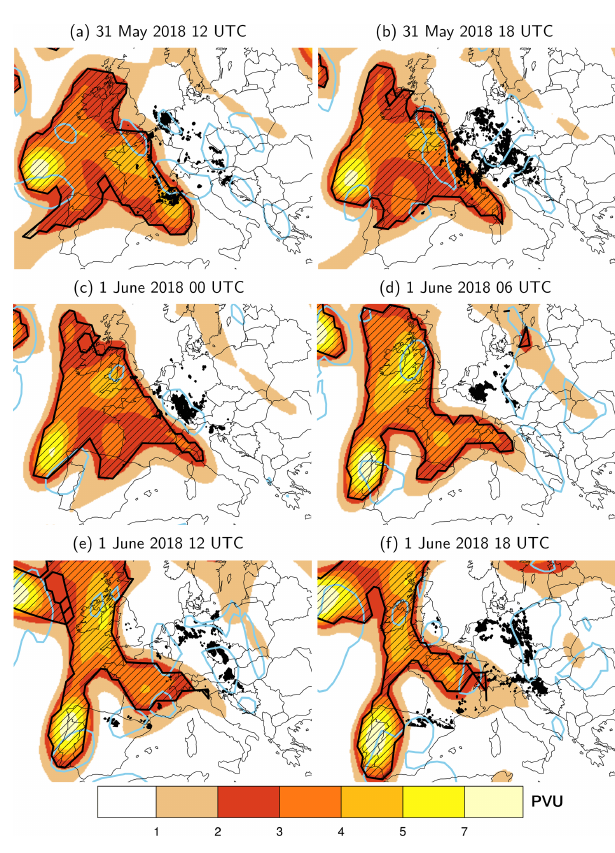
Figure 12. Lightning data (dark black dots) for 6h time spans centred around the respective time and PV on the 325K isen- tropic surface (shaded in PVU; ERA-Interim). Regions of ascent at 500hPa are indicated by light blue contours ( ω = − 0 . 1Pas − 1 ; ERA-Interim). Hatching indicates masks of objectively identified cut-offs on the 325K isentropic surface (see Fig. S2 including the buffer